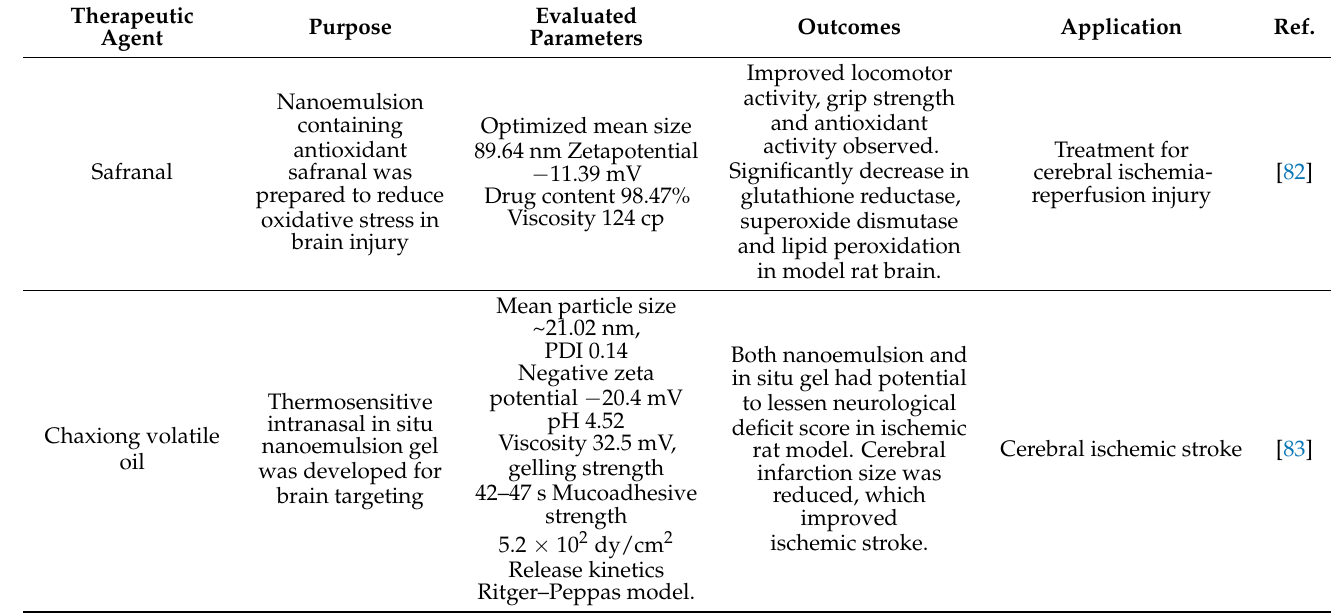
Table 4. Recently reported nanoemulsions for the management of cerebral